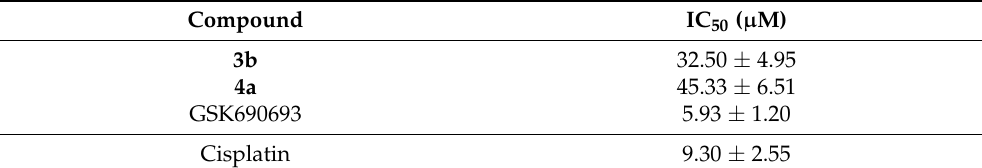
Table 6. Akt inhibitory effects of compounds 3b , 4a , GSK690693, and cisplatin in A549 cells.